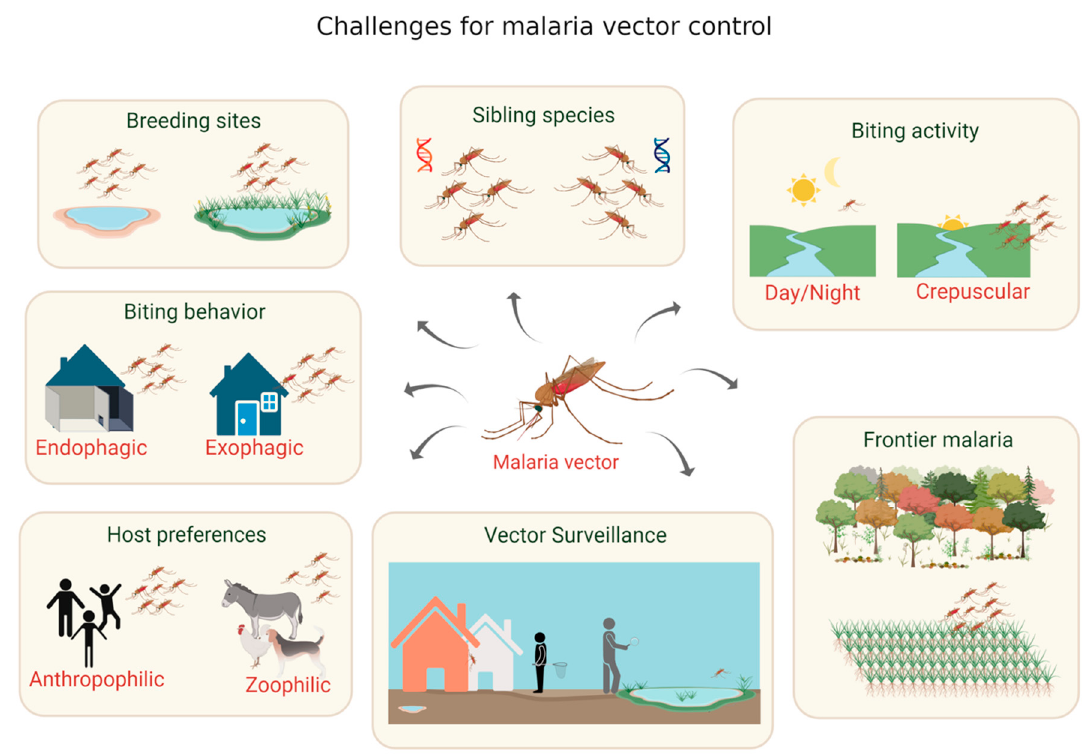
Figure 2. Main challenges for the development of novel vector-focused malaria control tools. Created with BioRender.com.